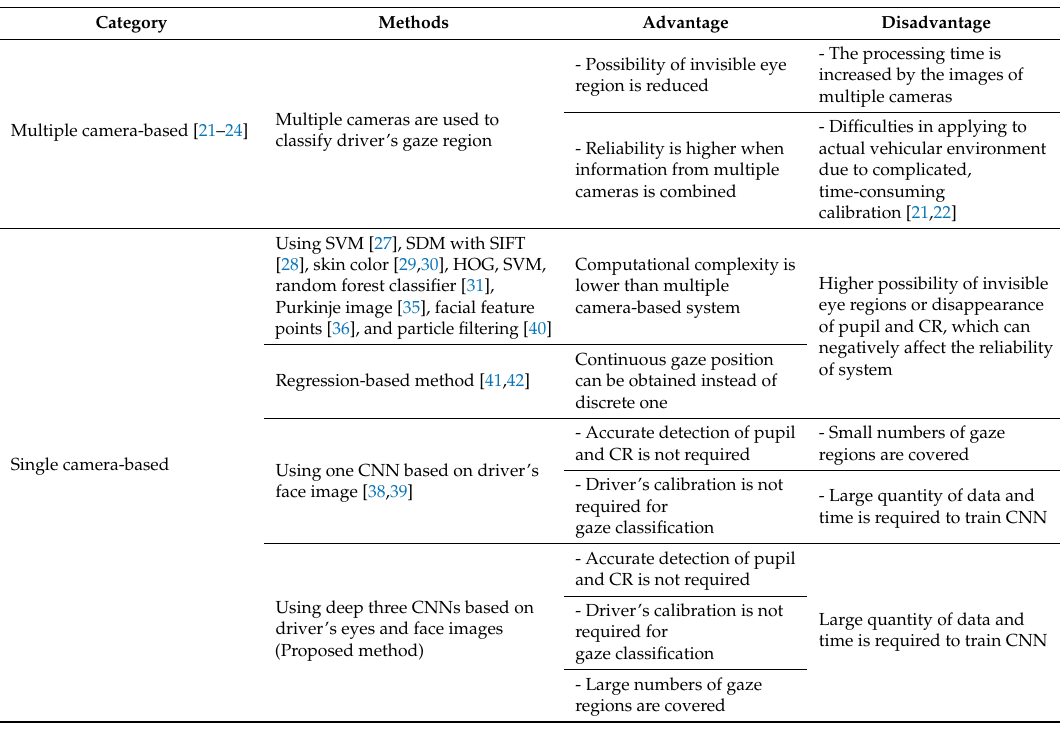
Table 1. Comparison between the proposed and previous research on gaze classification in vehicle